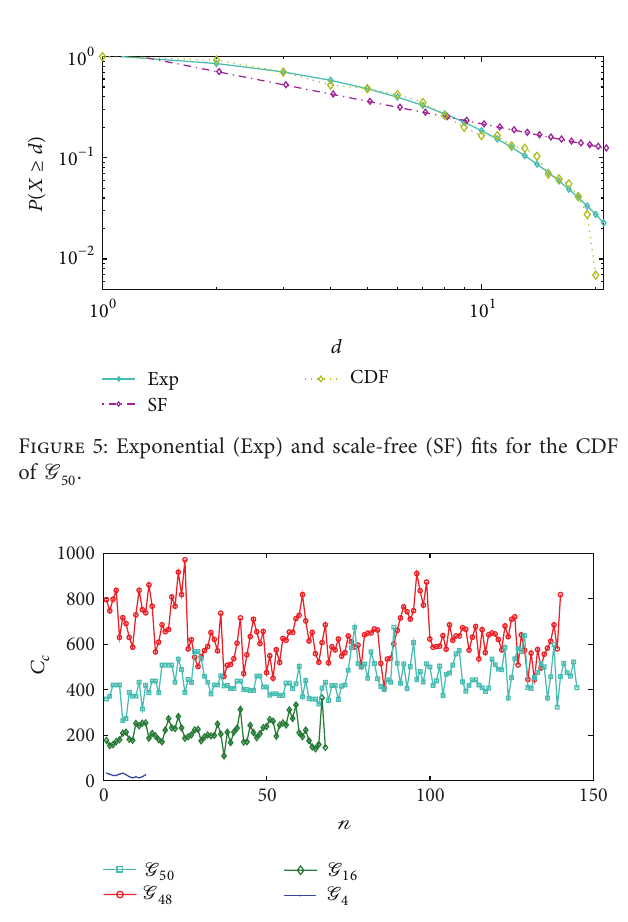
Figure 6: Closeness of the test power